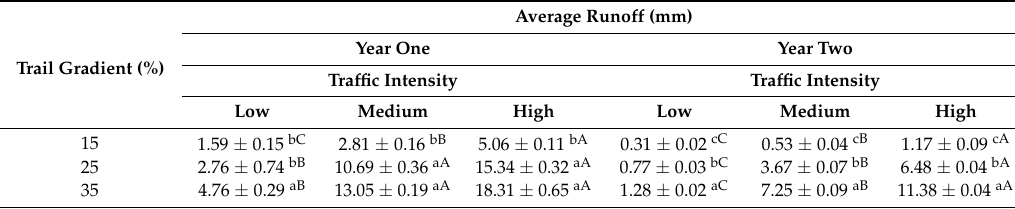
Table 3. Means ( ± std) of runoff (mm) on different trail gradients, traffic intensities, and years.